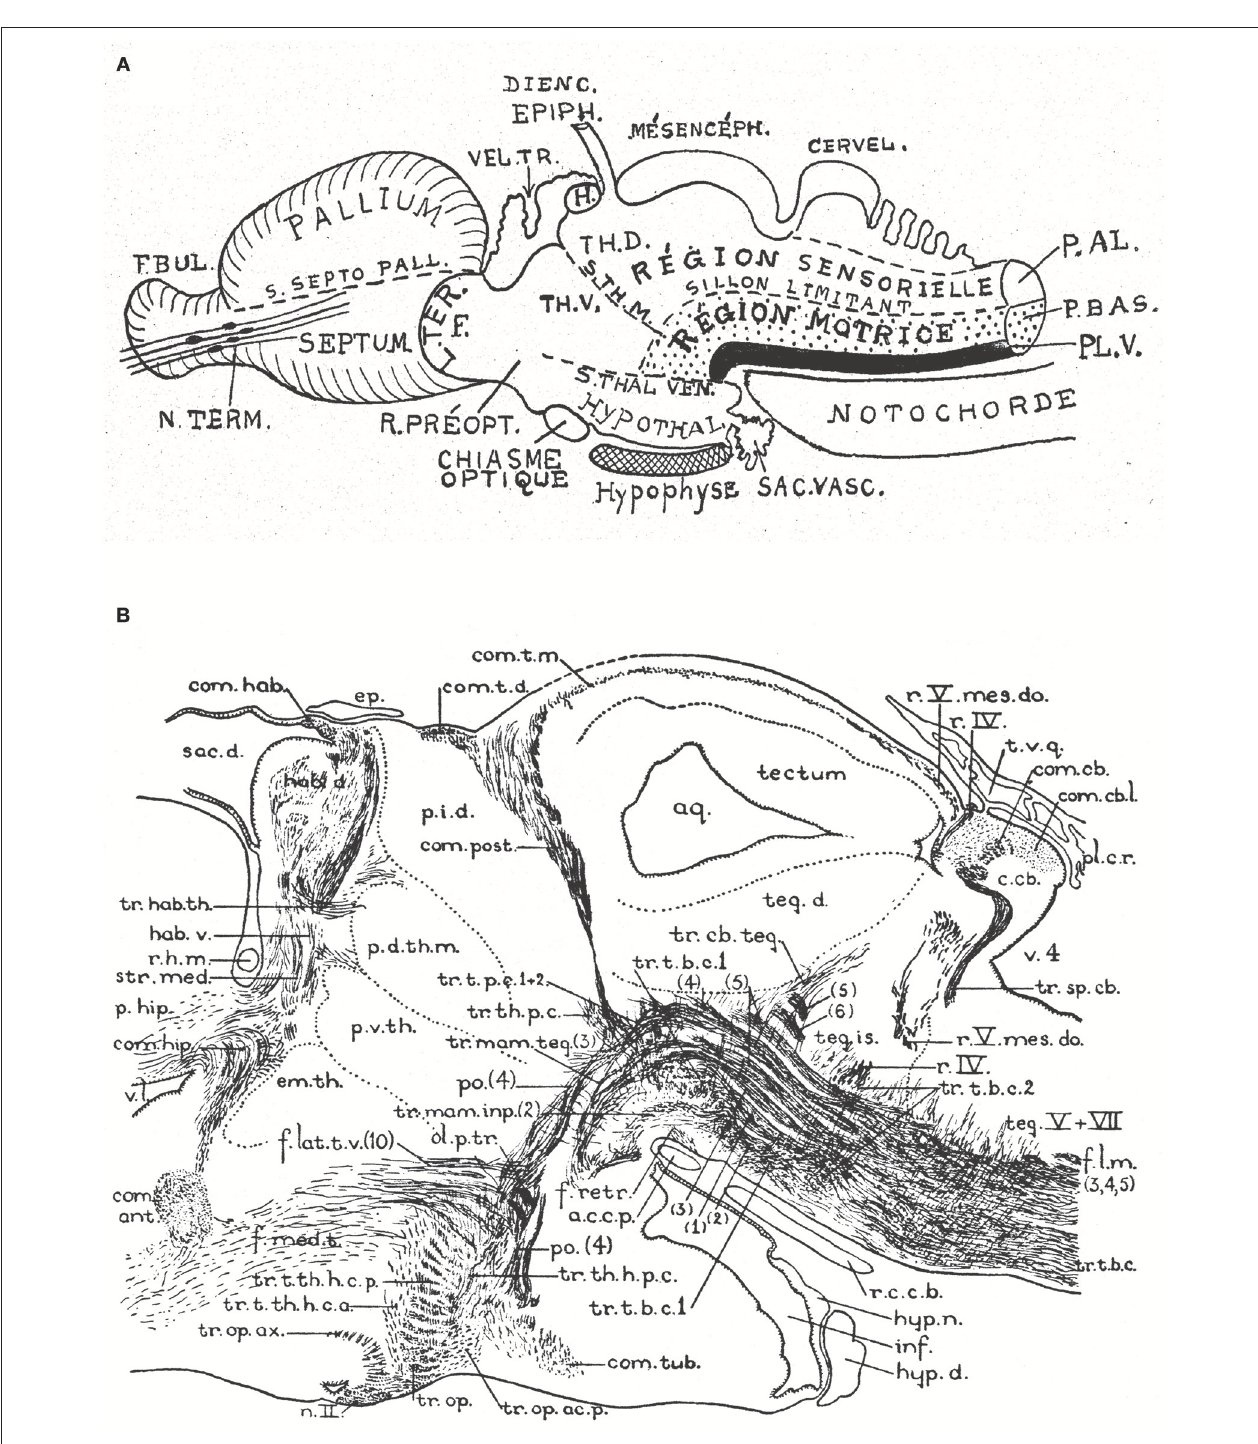
FIGURE 6 | Two classic images showing evidence that supposed longitudinal diencephalic columns actually represent transversal forebrain domains (no copyright permission required). (A) Schematic drawing of a primitive anamniote brain by Kappers (1947) that includes on one hand the basic floor, basal, alar and roof longitudinal zones of His (1893) (region sensorielle = alar plate; region motrice = basal plate; sillon limitante = sulcus limitans of His; the floor plate is in dense black; note its rostral end is roughly correlated with the tip of the notochord). Herrick’s (1910) thalamic sulci stm and stv that limit the DTh, VTh, and HTh columns are also represented. Kappers here clearly implies that he thinks that these sulci and “columns” are transversal, since he draws them orthogonal to the longitudinal zonation system. (B) This drawing is a very realistic rendering by Herrick (1936) of a fiber-stained sagittal section through the brain of Amblystoma (an urodele). Note a cephalic